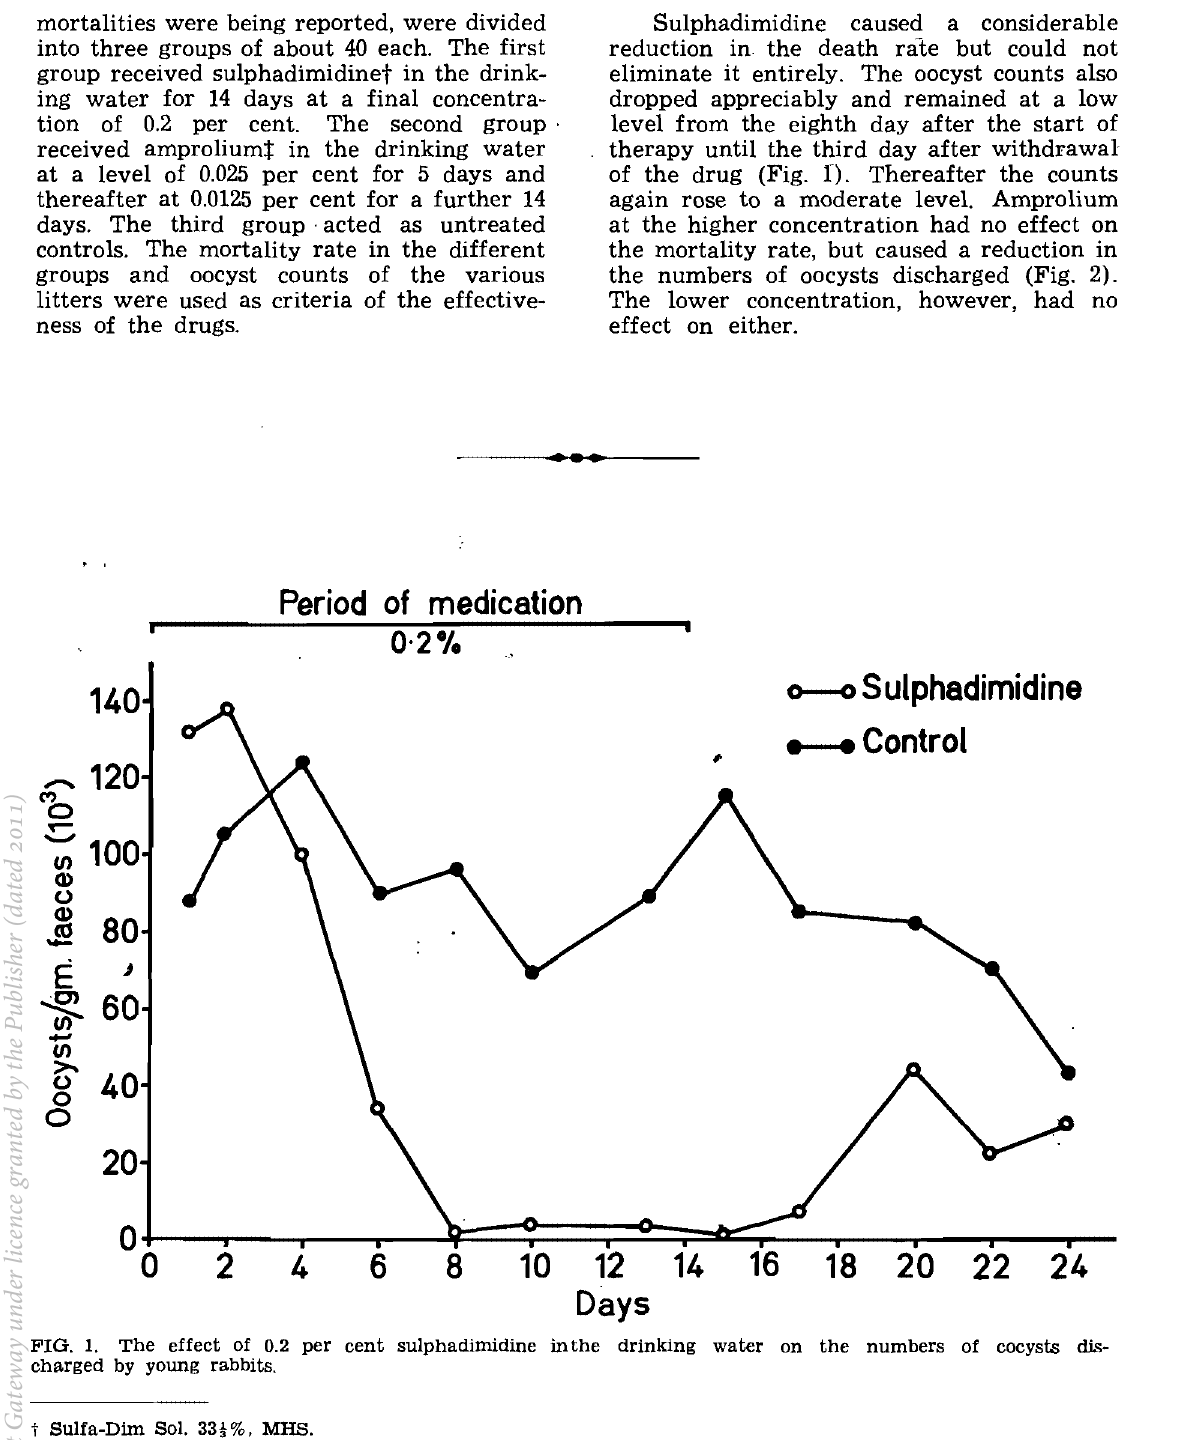
FIG.!. The effect of 0.2 per cent su!phadimidine inthe drinking water on the numbers of cocysts dis charged by young rabbits. t Sulfa-Dim Sol. 335%. MHS. t Ampro! 20%.